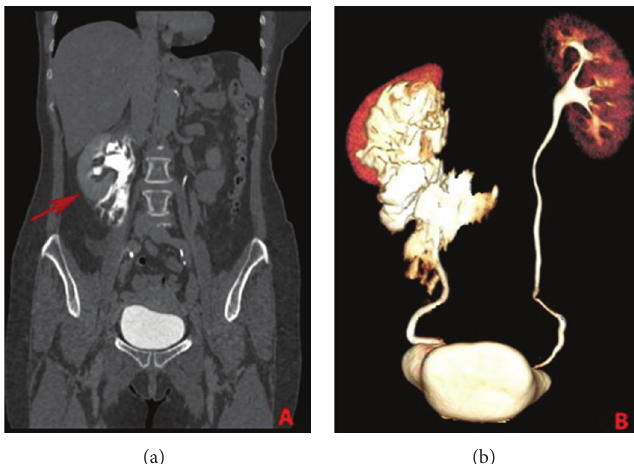
Figure 1: Contrast enhanced CT coronal image (a) and VR reconstruction (b) in the delayed phase documenting contrast extravasation extension (arrow).